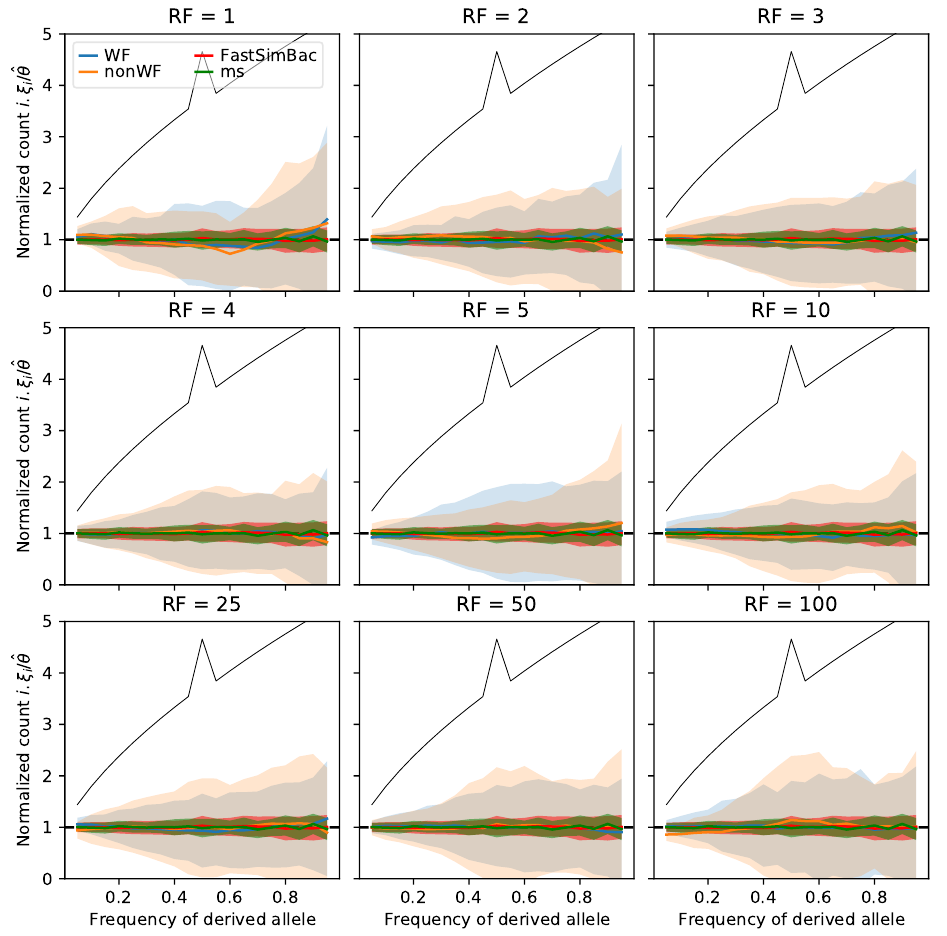
Figure S3 – The normalized Site Frequency Spectrum (SFS) for different rescaling factors. The shaded area represents one standard deviation (mean std). The horizontal line at ± 1 is the expected normalized SFS and the black line represents the expected standard deviation, both under the WF model. Parameters used: chromosome size: 2Mb; µ = ρ = 1 . 53 10 − 9 ; Ne = 140k; 20000 generations. The left two panels represent the SFS of × the WF simulations comparing different rescaling factors (top left) and comparing to the coalescent simulators (bottom left). The same information is shown on the right-hand side of the figure, but for the nonWF simulations. Rescaling does not affect the shape of the SFS and it matches that of the expected horizontal line at 1, is not different across rescaling factors, and is similar to the SFS obtained with the coalescent